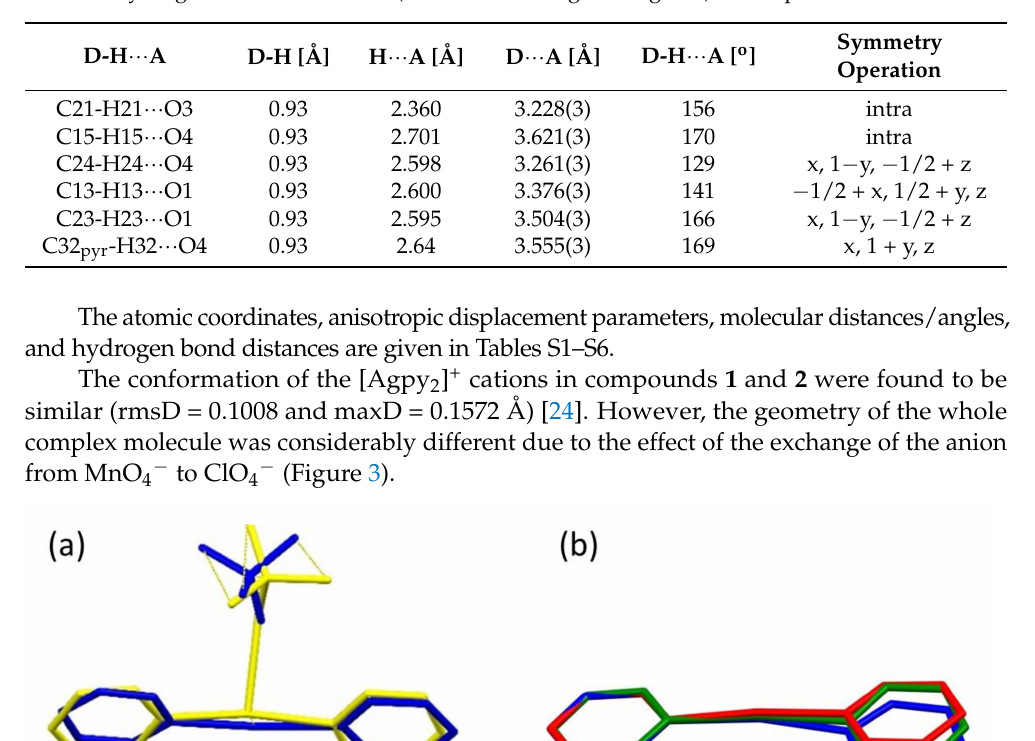
Figure 2. The centrosymmetric dimer of [Agpy 2 ClO 4 ] 2 ( a ) and the C α -H (pyridine ligand) ··· O (perchlorate) interactions ( b ) in the dimer of compound 1 . Table 2. Hydrogen bond interactions (distances and angles are given) in compound 1 .